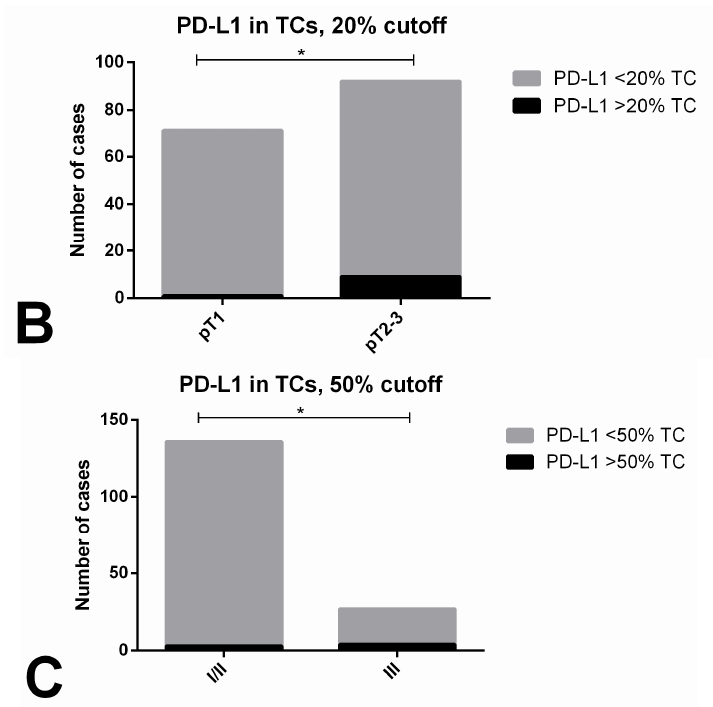
Figure 6. Immunoexpression of PD-L1 in tumor cells of testicular germ cell tumor subtypes and association with clinicopathological features. ( A ) association between PD-L1 positivity and lymphovascular invasion; ( B ) association between PD-L1 positivity above the 20% cutoff and pT stage; C ) association between PD-L1 positivity above the 50% positivity and TNM staging. Abbreviations: TC—tumor cells; LVI—lymphovascular invasion. * refers to p < 0.05.